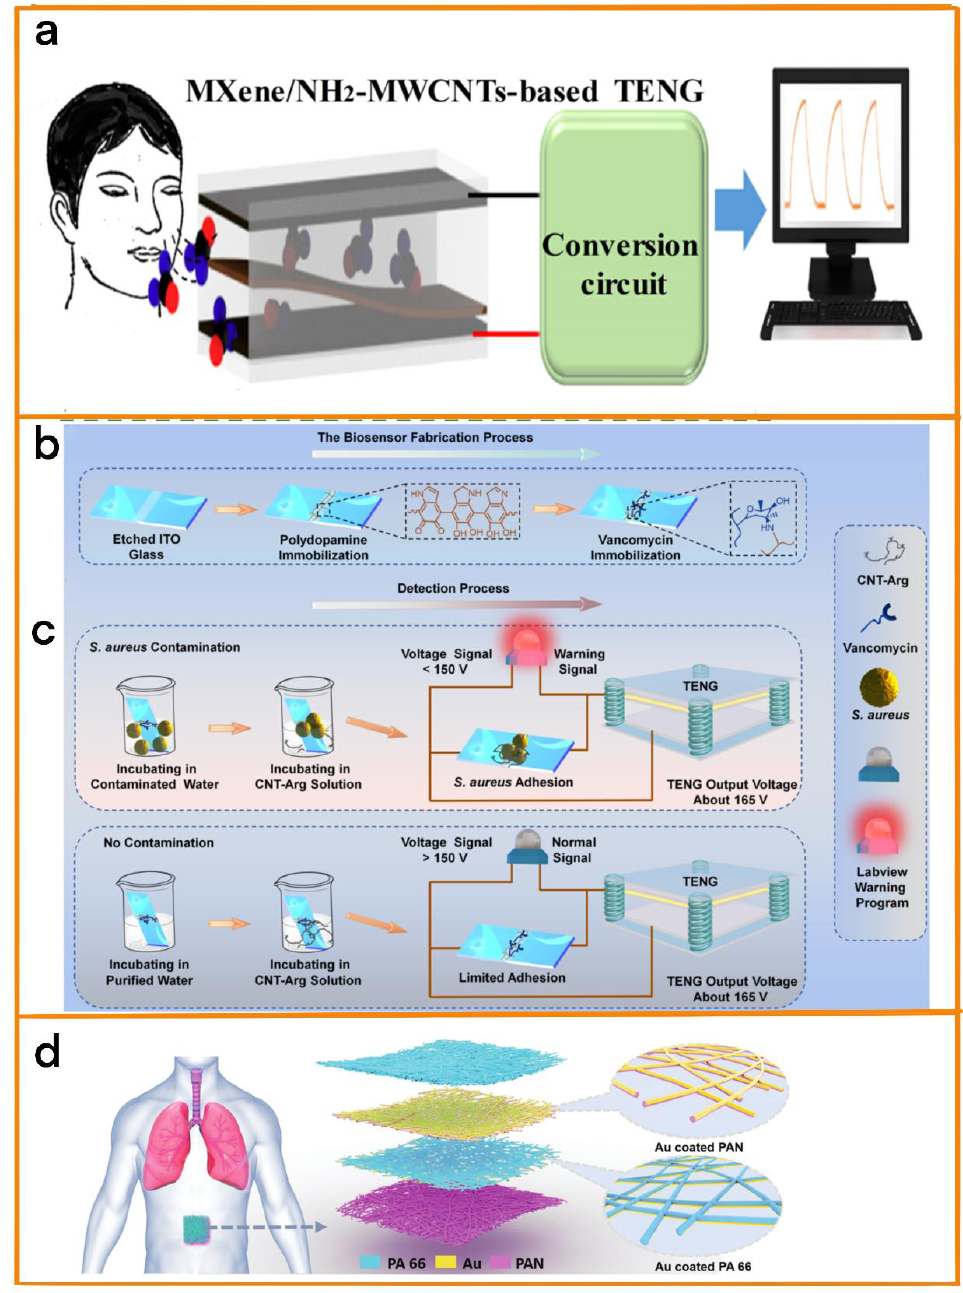
Figure 6. ( a ) Application diagram of MXene/NH2 − MWCNTs-based TENG. Reprinted with permis- sion from [60]. 2022, Elsevier. ( b ) The preparation process of ITO-Van, which is able to specifically capture Staphylococcus aureus, including the immobilization of dopamine and vancomycin on the etched surface of ITO glass. ( c ) Schematic diagram of staphylococcus aureus detection using a self- powered biosensor system. In the process of detecting Staphylococcus aureus, a liquid environment is assumed, and a vertical contact-separation TENG is used as the voltage signal source. Reprinted with permission from [62]. 2022, Elsevier. ( d ) SANES attached to the abdominal surface used in a respiratory monitoring application scenario; SANES schematic diagram; and an enlarged view of PAN nanofiber film and PA 66 nanofiber film coated with an Au electrode layer. Reprinted with permission from [63]. 2021, Elsevier.